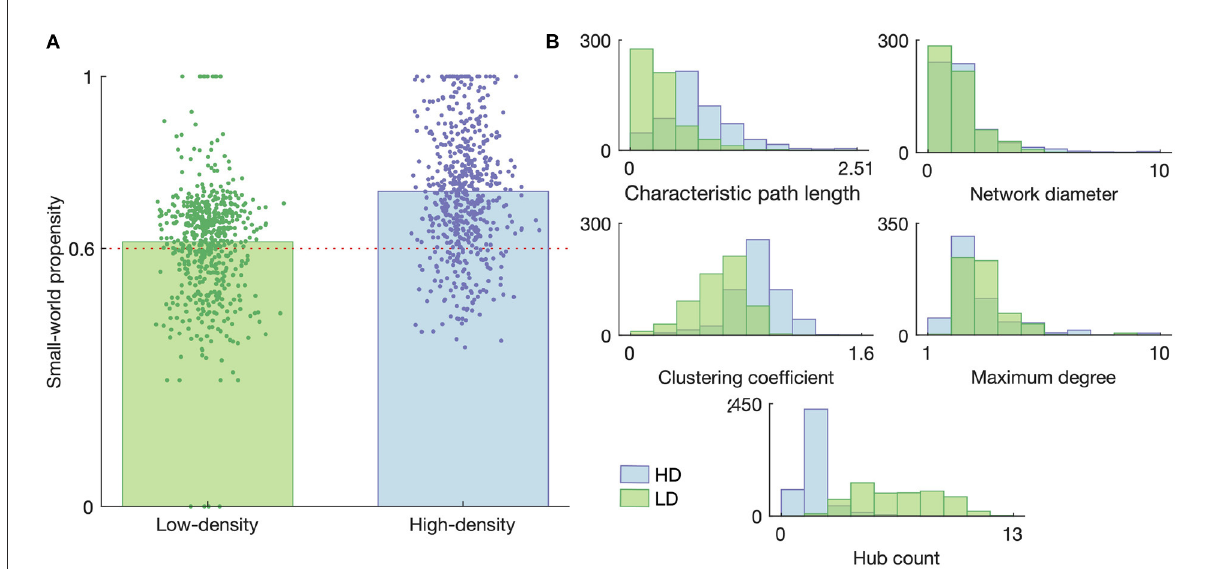
FIGURE7 Graph properties of the high- and low-density networks. (A) Small-world propensity. Each data point represents a functional connectivity graph obtained from network activity on a given day with a given time bin size; they are given random horizontal jitters for the sake of visualization. The heights of the bars represent the mean small-world propensity across all such graphs. The horizontal dashed line represents the threshold above which a graph is considered “small-world.” (B) Histograms of the small-world-normalized graph metrics considered in this study. Histograms represent graphs obtained on all DIVs with all considered time bin sizes.